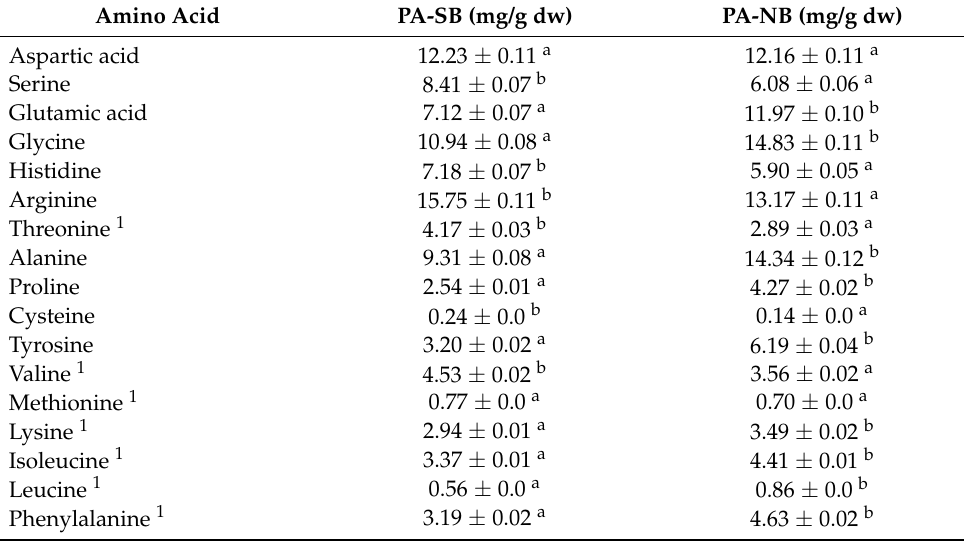
Table 5. Amino acid composition of seed cakes from P. alkekengi fruit phenotypes (PA-SB and PA-NB). Amino Acid PA-SB (mg/g dw) Aspartic